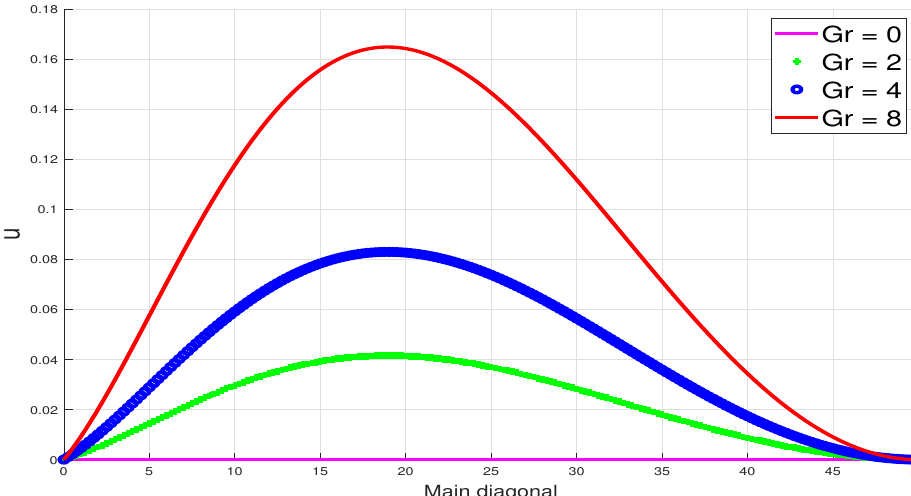
Figure 19. Temperature dependence on Gr at t = 5.